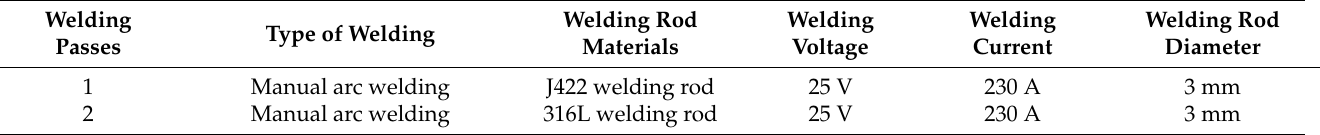
Figure 22. Schematic of clad rebar welding. Table 7. Welding process parameters for clad